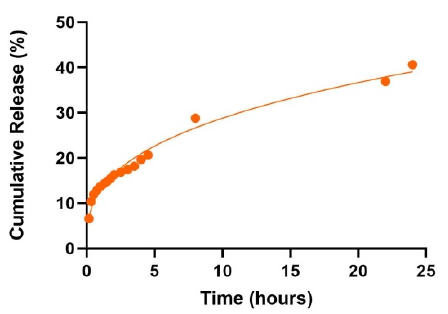
Figure 2. Release profile of compound 3c from liposomes and fitting to Korsmeyer–Peppas model.